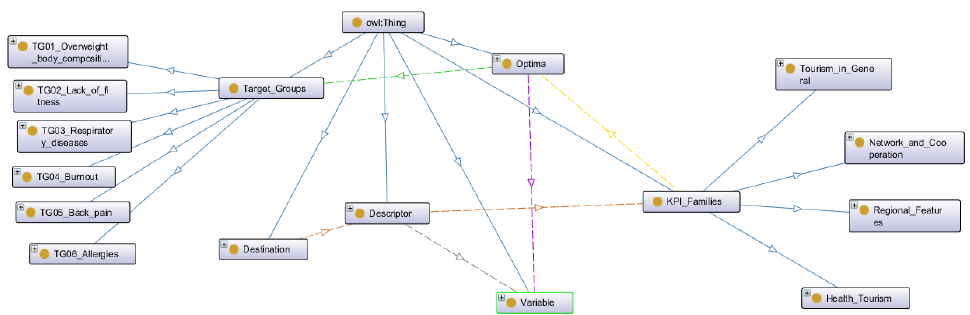
Figure 7. An excerpt of the main concepts of the ontology developed for Case 3 captured with Protégé ontology editor.